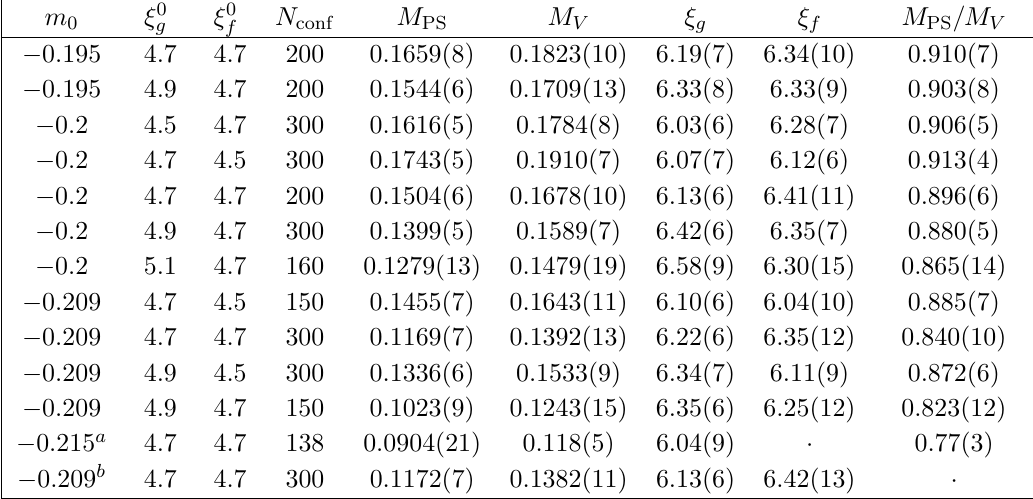
Table 3 . Simulation parameters and results for the tuning of the lattice bare parameters of an anisotropic lattice. The masses of pseudoscalar (PS) and vector (V) mesons are measured in units of a t